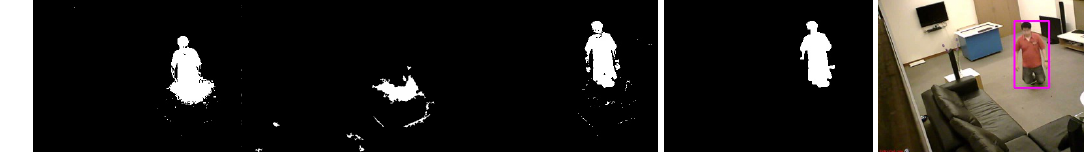
Figure 4. Human extraction result. First frame correspond to the Codebook result, the second one is the shadow detection. with simple subtraction between CB result and shadow detection, we get the third frame. After applying the second step from post processing, we get the result in the fourth frame. The last frame illustrates the tracked object correspond to the human